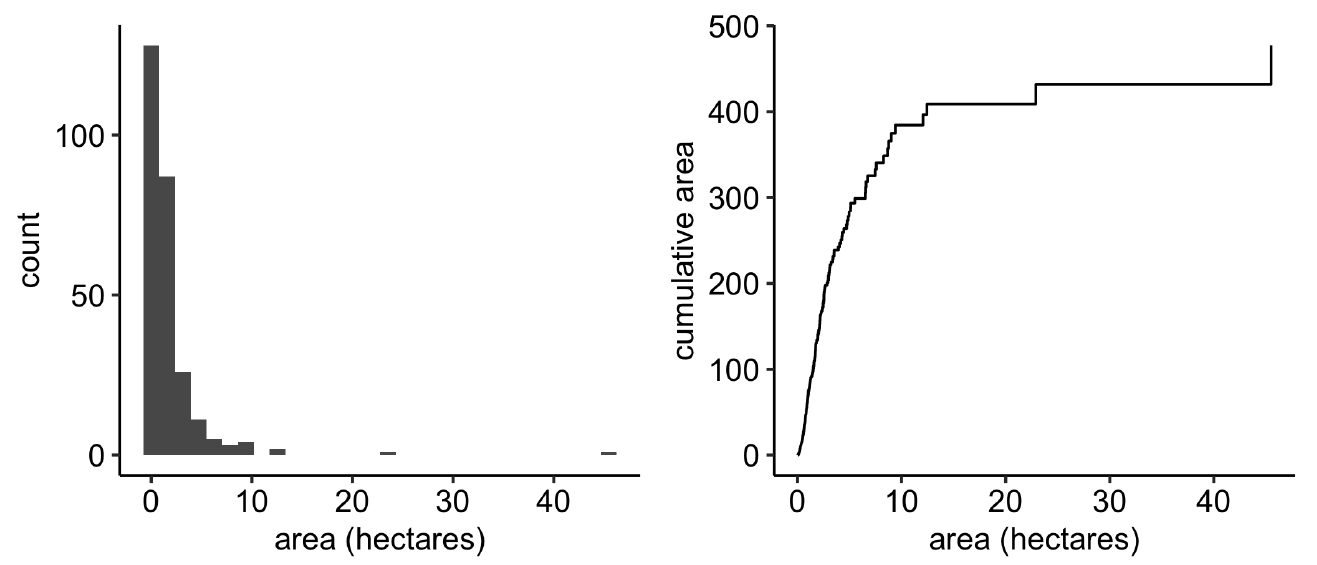
Figure 3. Histogram showing the count of Renosterveld loss events of different sizes ( left ), and the cumulative area lost by events of increasing size ( right ).